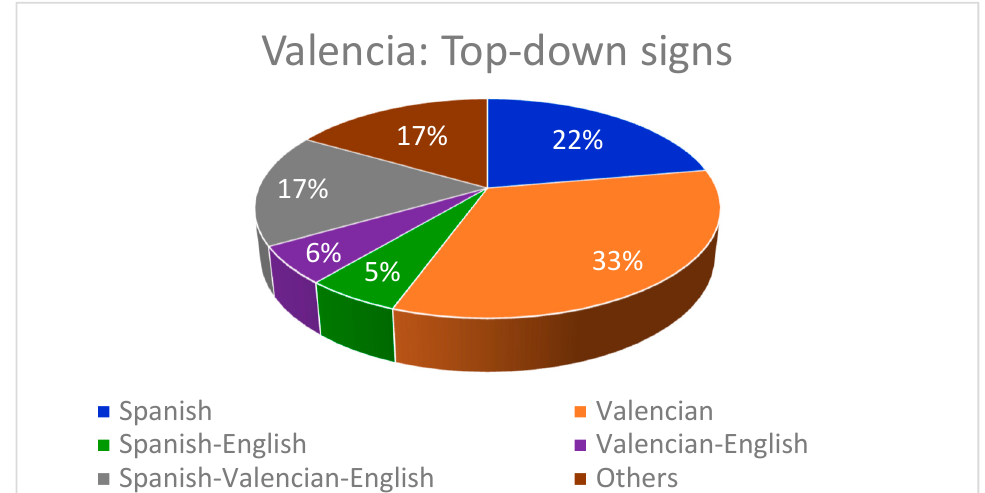
Figure 17. Valencia: Top-down signs .